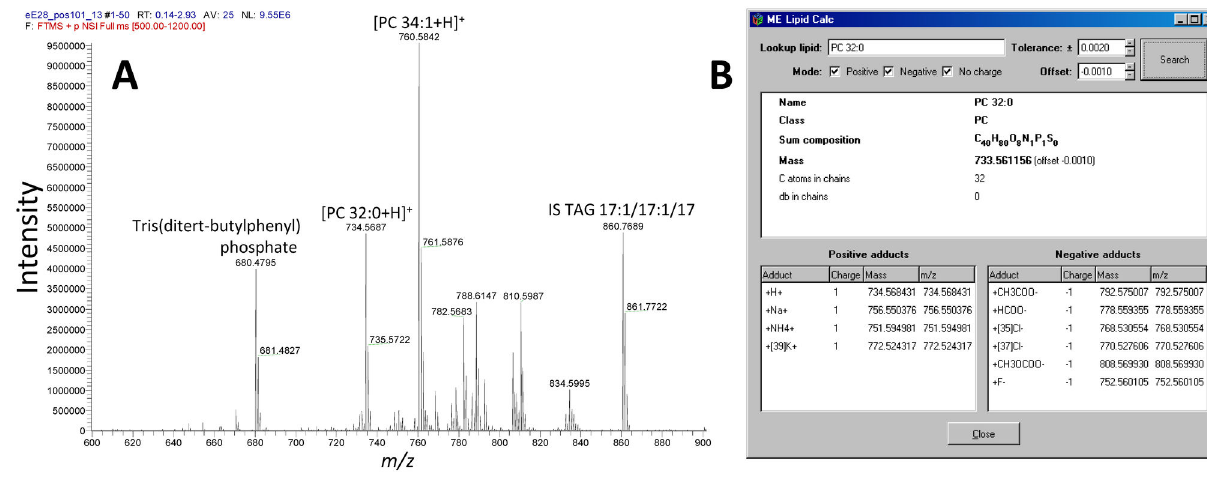
Figure 2. The ALEX lipid calculator. ( A ) Representative positive ion mode FT MS spectrum of a 10:1-phase lipid extract of hippocampus from a PRG-1 knockout mouse. Note that the detection of selected lock mass ions tris(ditert-butylphenyl) phosphate (chemical background, [M+NH ] + , calculated m/z 680.48022, measured m / z 680.47945, m / z offset = -0.00077) and TAG 4 17:1/17:1/17:1 (internal standard (IS), [M+NH ] + , calculated m/z 860.77017, measured m / z 860.76889 and m / z offset = -0.00128). 4 The FT MS calibration offset is estimated as the average of the m/z offset for both lock mass ions, i.e. the FT MS calibration offset = -0.0010. ( B ) Screenshot of the ALEX lipid calculator showing information for endogenous lipid species PC 32:0 while applying the FT MS calibration offset = -0.0010. Note that the measured m/z of PC 32:0 is 734.56872 and that the calculated m/z adjusted for the calibration offset is 734.56843 which yield a m/z difference of 0.00029 corresponding to a mass error of 0.4 ppm. Without applying lock mass adjustment the mass error would be 1